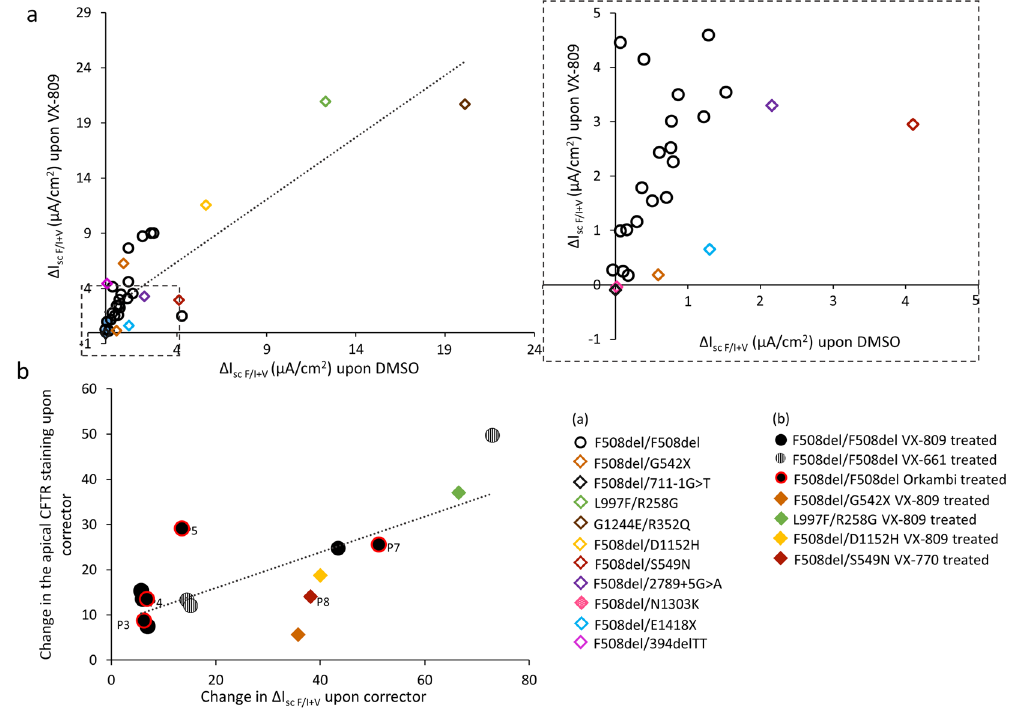
Figure 5. Lumacaftor stimulated CFTR activity correlates with basal CFTR activity among different genotypes. ( a ) Correlation of lumacaftor-stimulated CFTR activity (y-axis, ∆ I scF/I + V after treatment for 48 h at 37 °C with lumacaftor 3 µ M) and basal CFTR activity (x-axis, ∆ I scF/I + V after treatment for 48 h with DMSO). The dotted line shows simple regression analysis of the data ( R 2 = 0.74, p < 0.0001). Legend included in the figure. Inset showing the specific values for ∆ I scF/I + V < 5 µ A/cm 2 . ( b ) CFTR corrector-stimulated CFTR activity changes (x-axis, ∆ I scF/I + V ) correlated with changes in the apical CFTR expression (y-axis, apical CFTR staining). The CFTR activity change is the difference between ∆ I scF/I + V after treatment for 48 h at 37 °C with lumacaftor 3 µ M and ∆ I scF/I + V after treatment for 48 h with DMSO, expressed as percentage of the mean ∆ I scF/I + V value in wt/wt cells. Apical CFTR expression change is presented as the difference between the apical CFTR staining after treatment for 48 h at 37 °C with lumacaftor 3 µ M and the apical CFTR staining after treatment for 48 h with DMSO, expressed as percentage of the mean apical CFTR staining in wt/wt cells. The dotted line shows simple regression analysis of the data ( R 2 = 0.6, p < 0.001; n = 15). Legend included in the figure. Circular points indicate F508del/F508del cells (black filled circles: lumacaftor treated; circles with lines: tezacaftor treated; black filled circles with red frame: Orkambi treated; HNEs obtained from CF patients before starting the Orkambi treatment are indicated by the letter P and a number), filled rhomboid points: other CF genotypes treated with lumacaftor or ivacaftor for